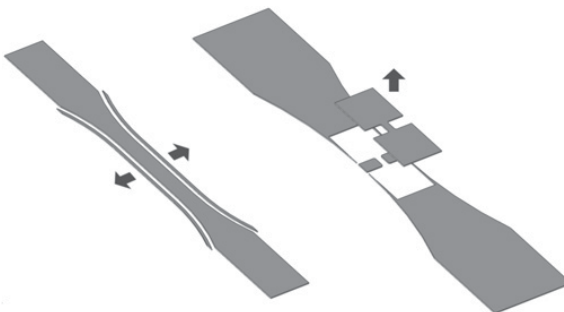
Fig. 3. Removal of edges from fatigued specimens before quasi- static tensile testing (left) and extraction of Hopkinson specimen from larger fatigue samples (right).